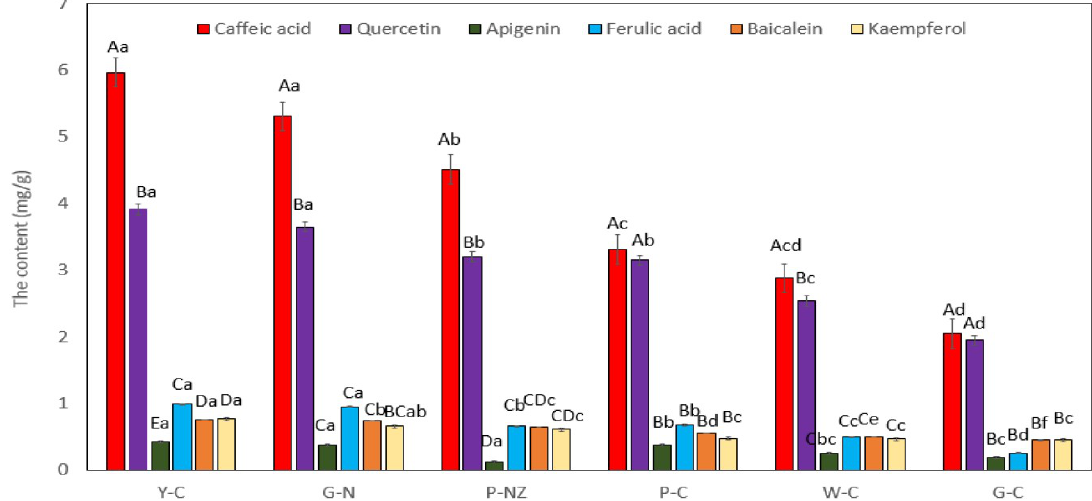
Figure 2. The contents of the six tested compounds in various AR samples. Data presented as mean ± SEM from three replicates ( n = 3) from each sample. Bars with different letters indicate that they are statistically different ( p < 0.05). The small letters mean the content of the same compound in different cultivars; whereas, the capital letters indicate the six tested compounds are compared within the same AR. Y-C = yellow Chinese asparagus root; G-N = green New Zealand asparagus root, P-NZ = purple New Zealand asparagus root; P-C = purple Chinese asparagus root; W-C = white Chinese asparagus root; and G-C = green Chinese asparagus root.